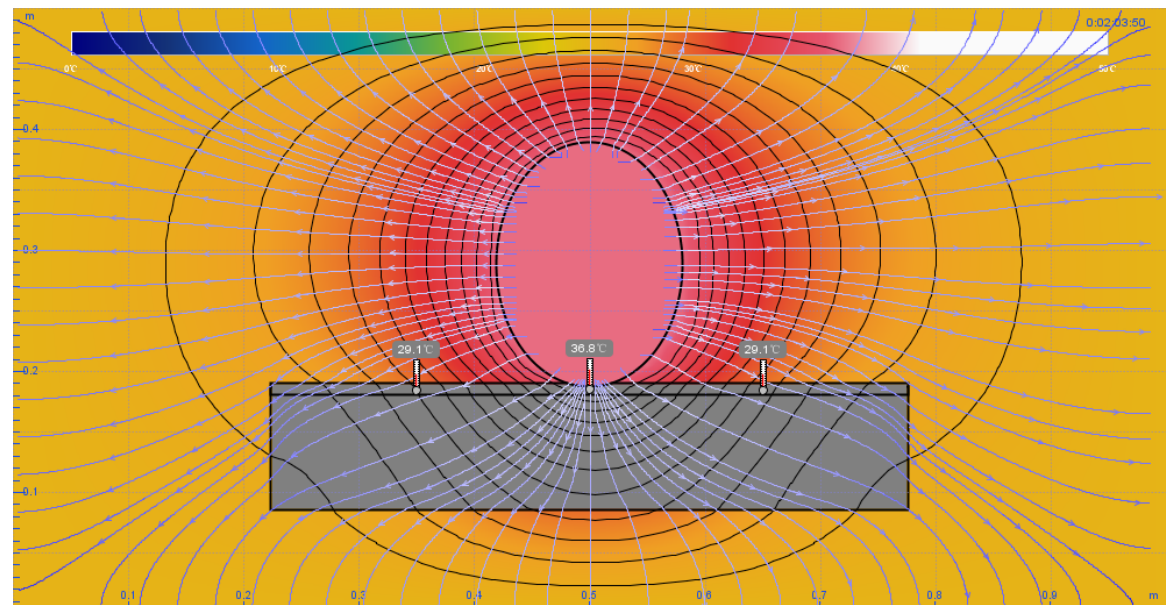
Figure 11. Simulation of the thermal distribution of the pillow.